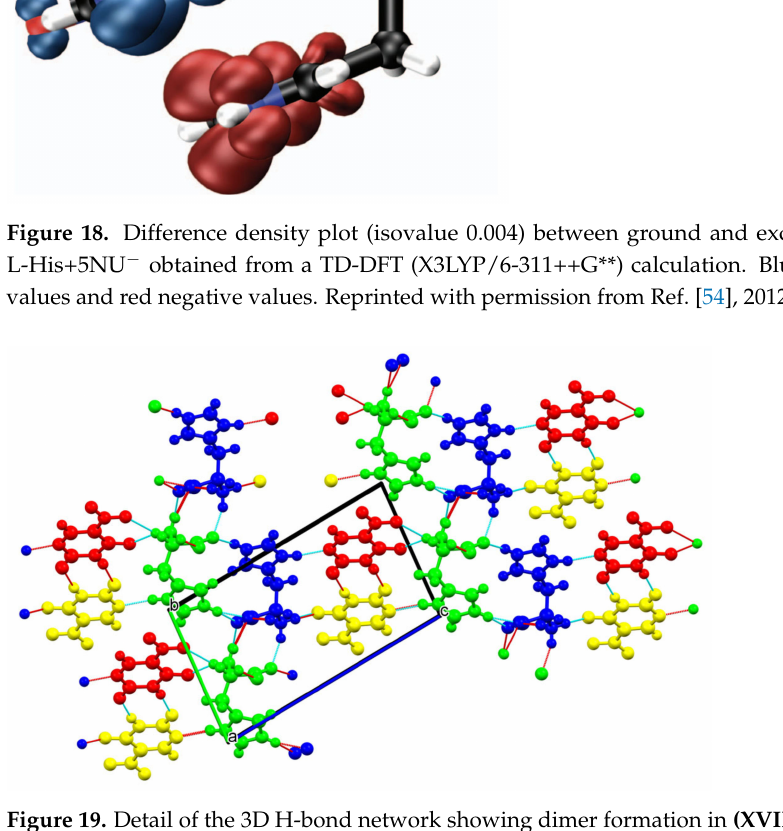
Figure 19. Detail of the 3D H-bond network showing dimer formation in (XVII)